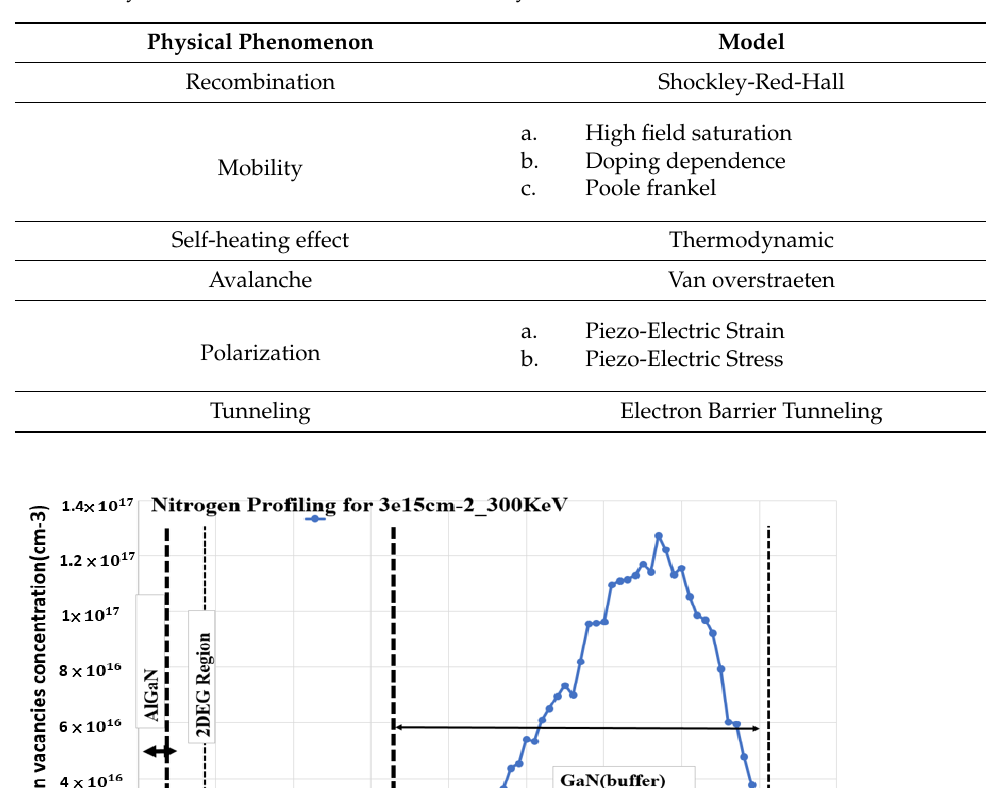
Figure 2. Simulated device structure with three various metal contact positions. Table 1. Physical models for simulation of normally off AlGaN/GaN HEMT device.